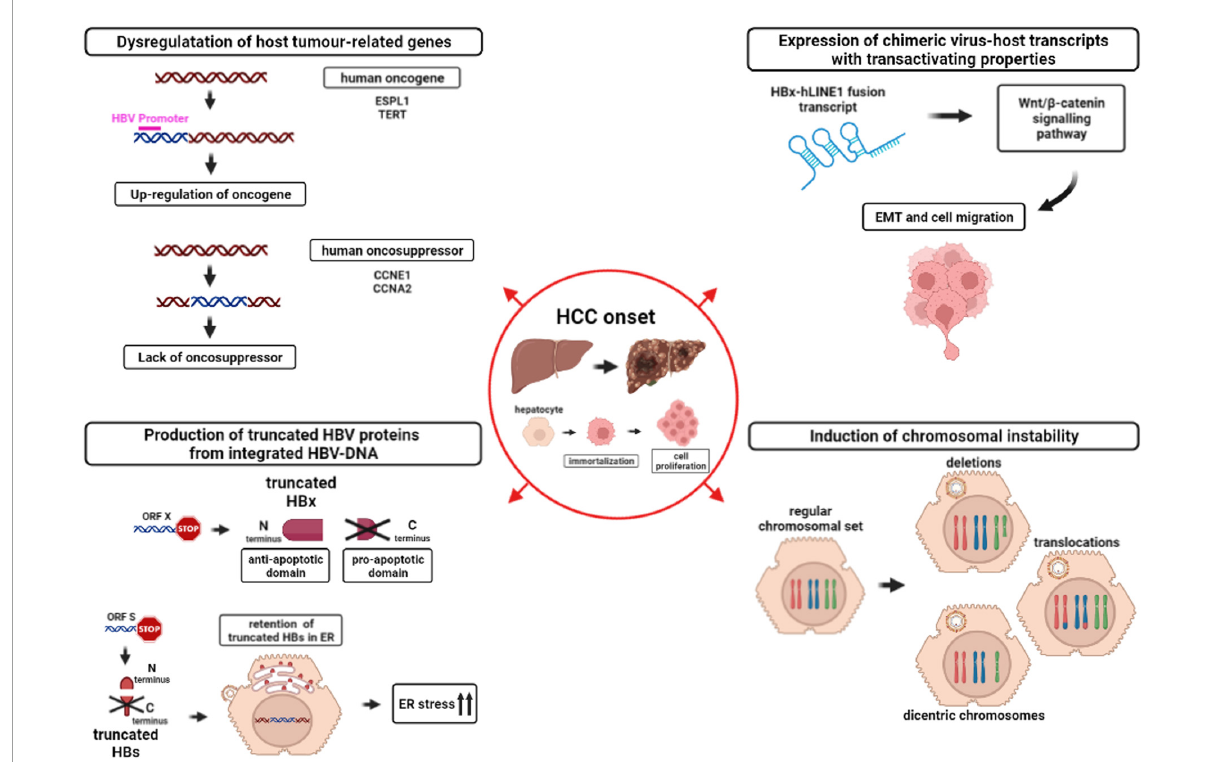
FIGURE3 Mechanisms involved in HCC onset caused by HBV-DNA integration into the host genome. The figure depicts the downstream effects of HBV-DNA integration favoring HCC onset: (i) Dysregulation of host tumor-related genes (top-left) due to the up-regulation of host oncogenes (red) or to the lack of oncosuppressors. Magenta line indicates a generic HBV promoter; (ii) Expression of chimeric virus-host transcripts with transactivating properties (top-right). HBx-human long interspersed nuclear element 1 (hLINE1) fusion transcript, derived from integrated HBV-DNA, can activate the Wnt/ β -catenin signaling pathway, leading to epithelial-mesenchymal transition (EMT) and cell migration; (iii) Production of truncated HBV proteins from integrated HBV-DNA (bottom-left) . HBV ORF X integration into the host genome can lead to the synthesis of a truncated HBx protein, retaining the anti-apoptotic N-terminal domain and lacking the pro-apoptotic C-terminal domain. Similarly, HBV ORF S integration can lead to the synthesis of truncated HBs proteins that are retained in the membrane of endoplasmic reticulum (ER), triggering ER stress, and in turn activating pro-oncogenic pathways; iv) Induction of chromosomal instability (bottom-right). The hepatocyte with a regular chromosomal set can develop chromosomal aberrations, such as deletions, translocations or dicentric chromosomes, as a consequence of HBV-DNA integration into the